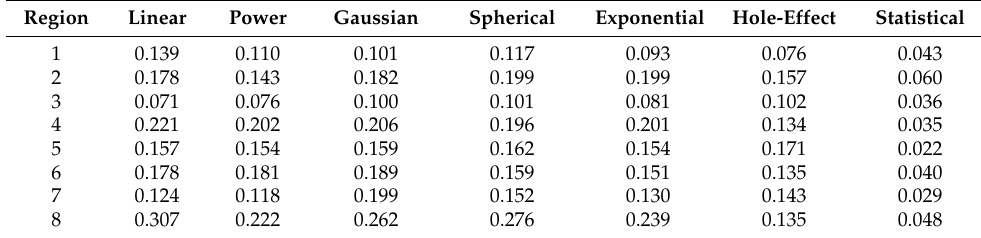
Table 2. The errors of statistical interpolation and kriging with different variogram models.